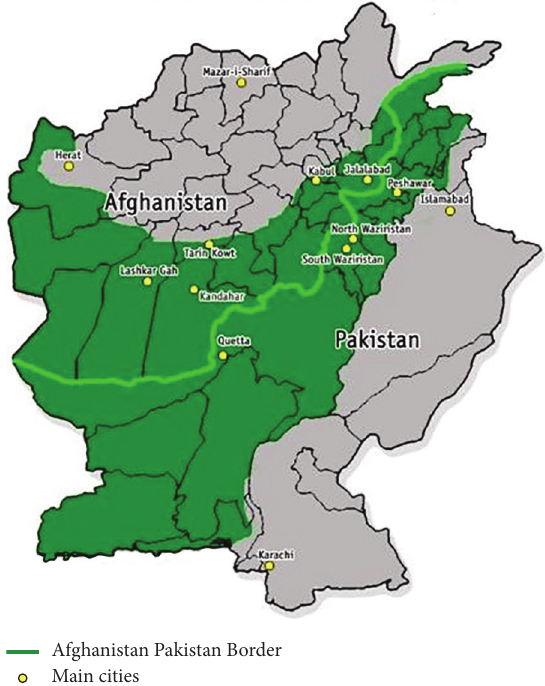
Figure 1: Regions where predominantly Pashto is spoken as the first language